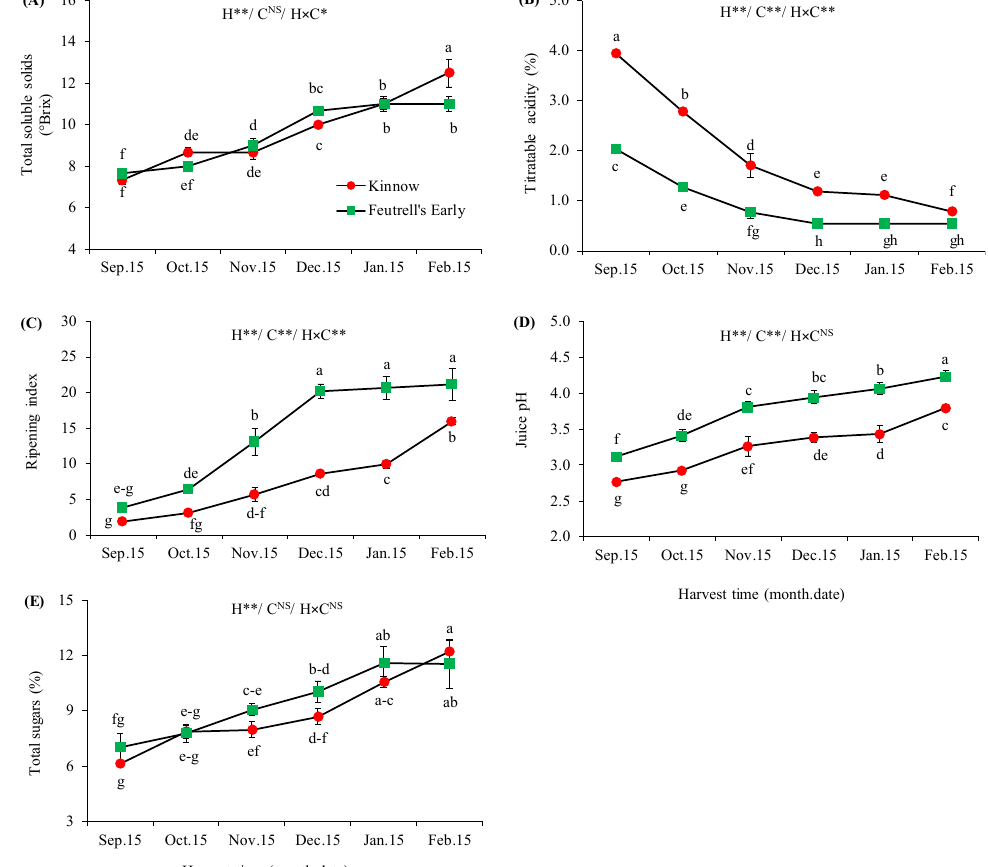
Figure 4. Changes in total soluble solids ( A ), titratable acidity ( B ), ripening index ( C ), juice pH ( D ), and total sugars ( E ) of mandarin fruits (Kinnow and Feutrell’s Early) at different harvest times. Error bars show standard errors of the means ( n = 4). Different lowercase letters in each graph indicate significant differences at p < 0.05 between tested samples at different times by the least significant difference test. H and C stand for harvest times and cultivar, respectively. H × C presents the effect of the interaction of harvest times and cultivar. NS, non-significant; significant at * p < 0.05 or ** p < 0.01.